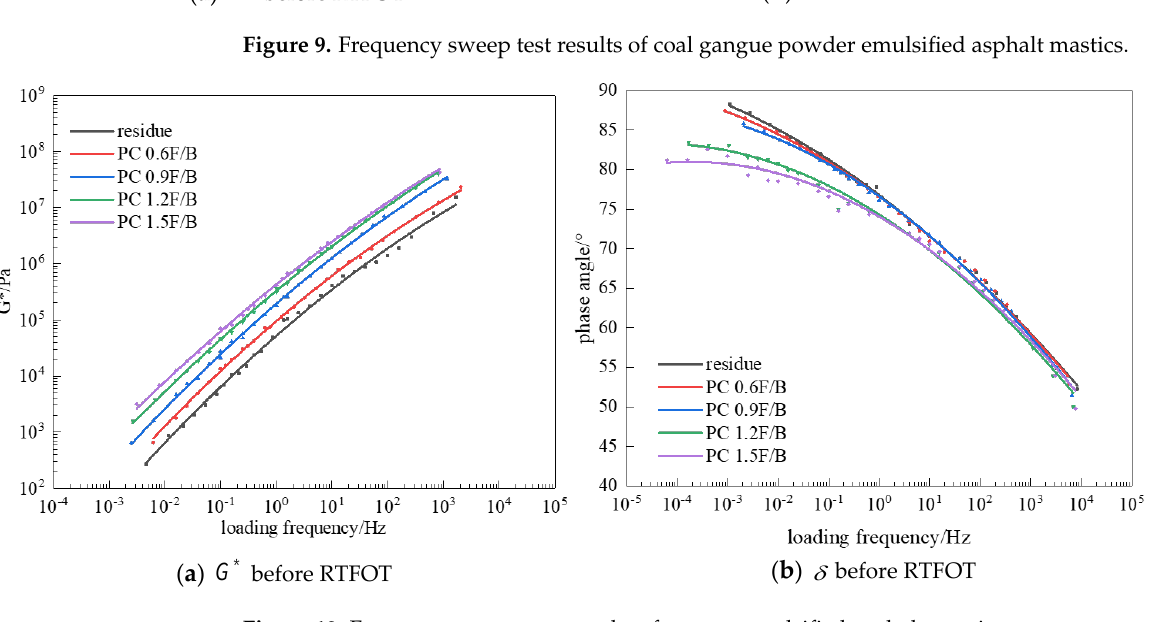
Figure 10. Frequency sweep test results of cement emulsified asphalt mastics.